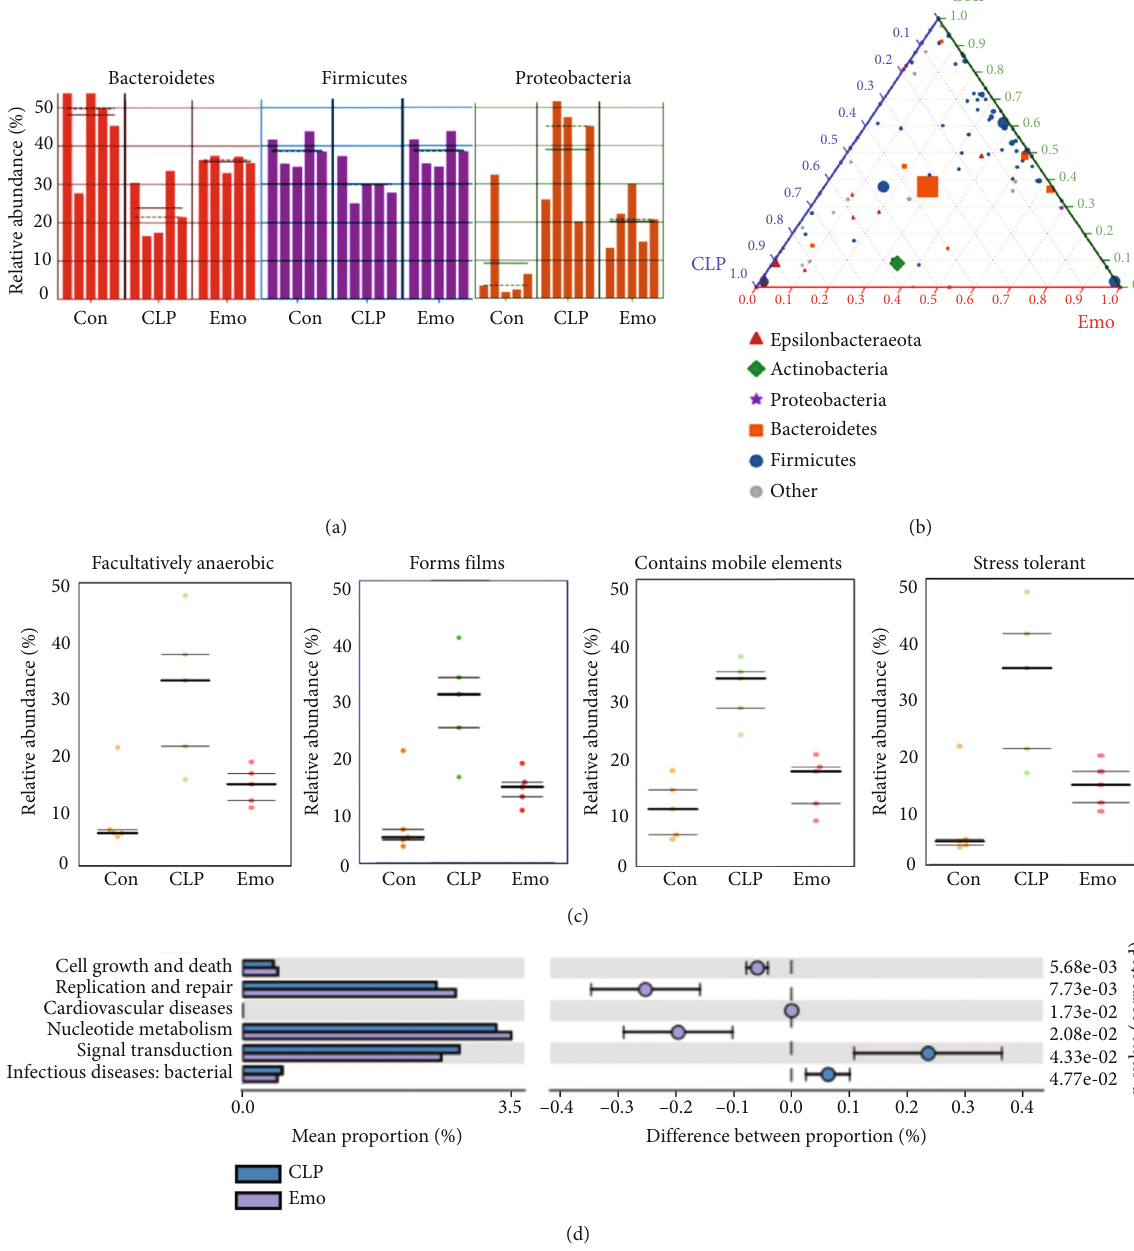
Figure 7: Functional analysis on the shift of microbiota in septic mice. (a) LEfSe analysis of samples between groups. The histogram of LDA value distribution and evolutionary branch graph of LEfSe analysis is illustrated. (b) Ternary diagram of samples between groups. The ternary diagram is drawn by using Python. The proportion and relationship of di ff erent species in the samples is shown through the triangle diagram. Green: control group; blue: CLP group; and red: Emo group. (c) BugBase function prediction. x -axis represents the group name, and y -axis represents the relative abundance percentage. The three lines are the lower quartile, the mean, and the upper quartile, respectively, from the bottom up. (d) COG function prediction. The analysis results are shown, re fl ecting the function distribution and abundance of the sequences in